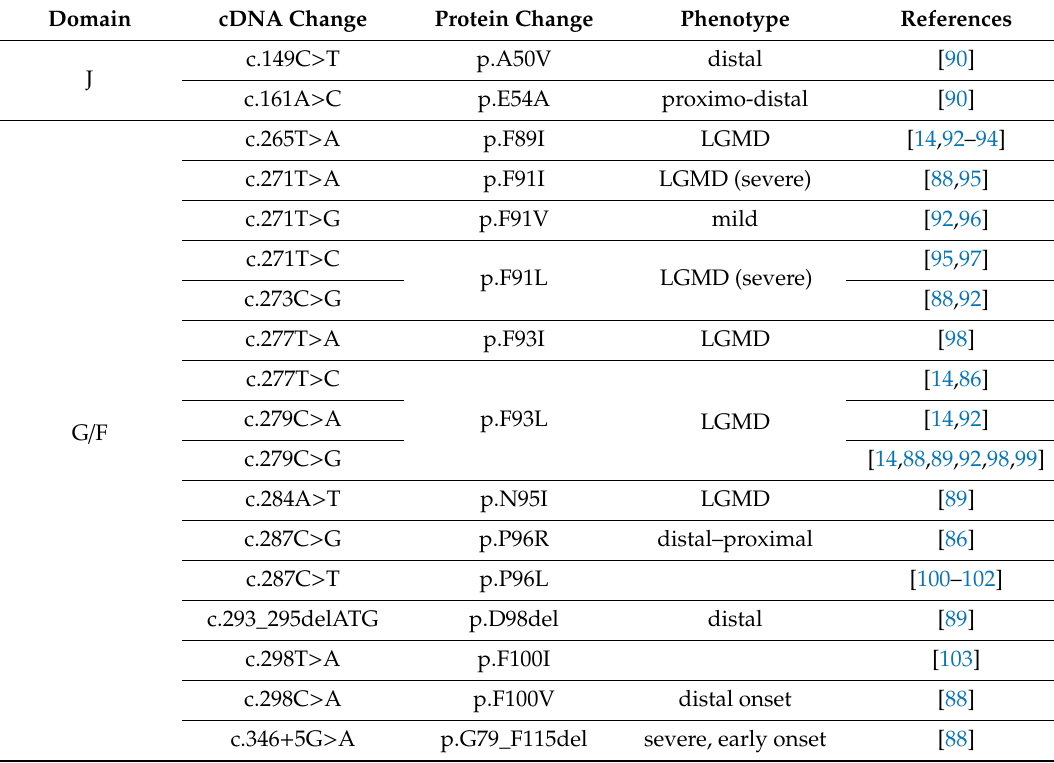
Table 2. DNAJB6 mutations causing neuromuscular